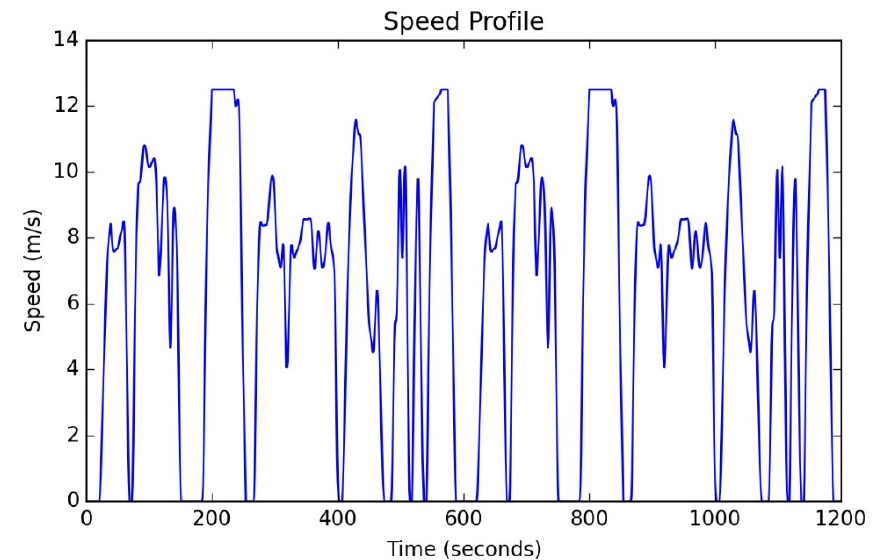
Figure 1. Speed profile from WMTC Reference Cycle 2.